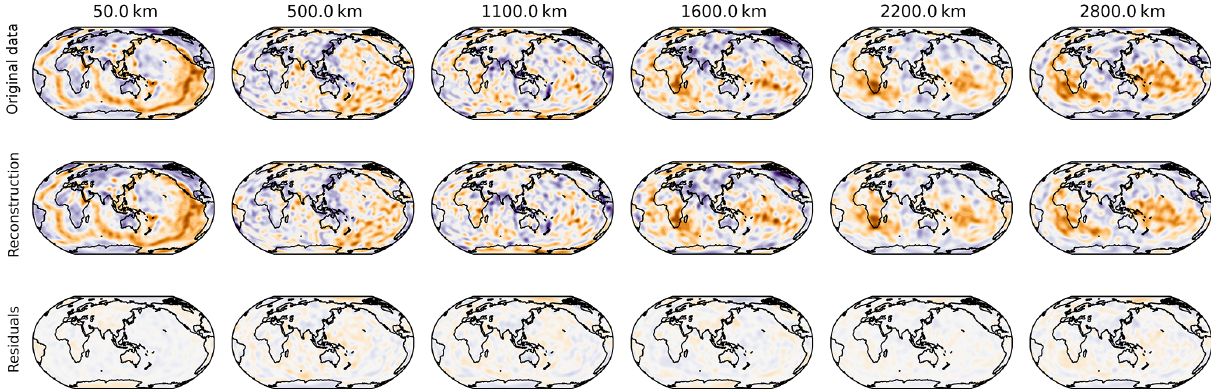
Figure B1. Examples of six depth slices in the original SEMUCB − WM1i model (top), in the model recovered without the principal compo- nents with less than 1% of the variance, i.e. with nine components (middle), and differences between the two